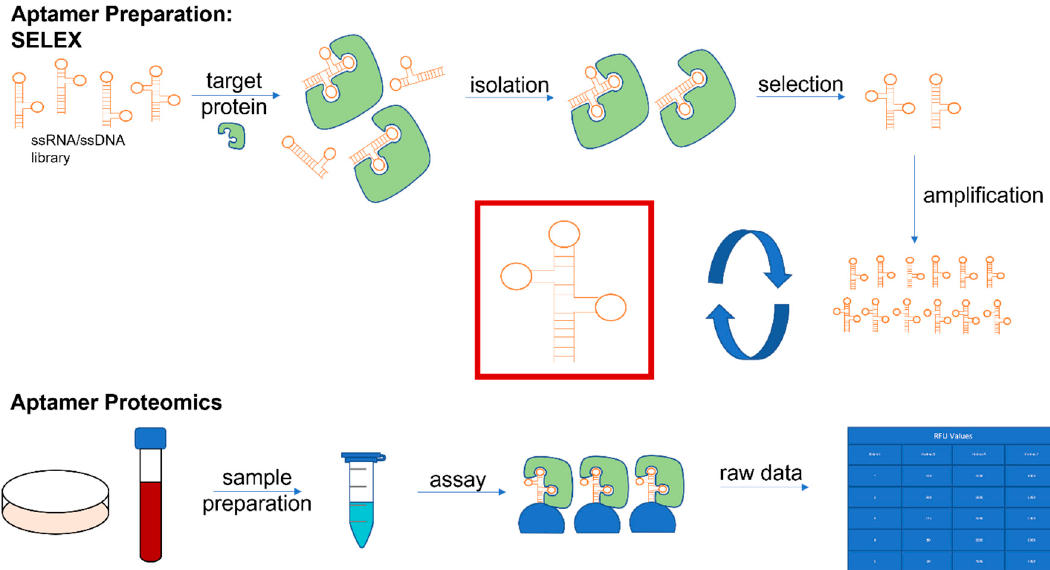
Figure 1. Generating proteomic datasets using aptamers.